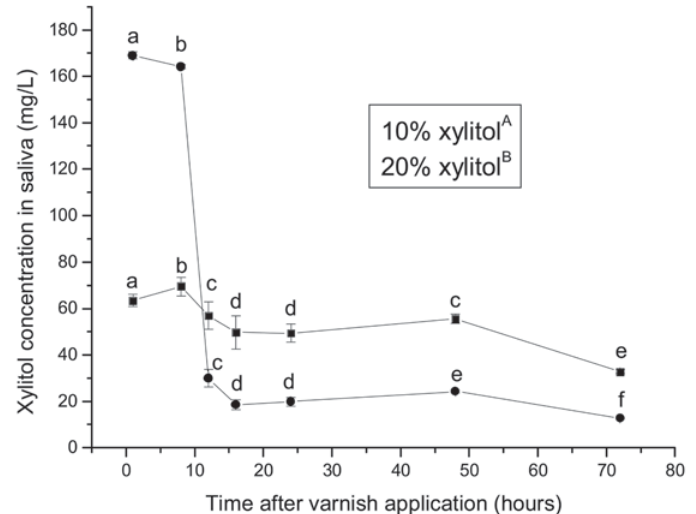
Figure 1- (cid:2)(cid:3)(cid:4)(cid:5)(cid:6)(cid:2)(cid:5)(cid:7)(cid:7)(cid:8)(cid:9)(cid:8)(cid:10)(cid:5)(cid:11)(cid:4)(cid:12)(cid:2)(cid:13)(cid:14)(cid:10)(cid:15)(cid:11)(cid:16)(cid:10)(cid:2)(cid:7)(cid:16)(cid:6)(cid:7)(cid:4)(cid:6)(cid:11)(cid:17)(cid:5)(cid:11)(cid:15)(cid:16)(cid:6)(cid:18)(cid:2)(cid:19)(cid:9)(cid:20)(cid:21)(cid:22)(cid:23)(cid:2)(cid:15)(cid:6)(cid:2)(cid:5)(cid:17)(cid:11)(cid:15)(cid:24)(cid:7)(cid:15)(cid:5)(cid:10)(cid:2)(cid:18)(cid:5)(cid:10)(cid:15)(cid:25)(cid:5)(cid:2)(cid:16)(cid:25)(cid:4)(cid:17)(cid:2)(cid:11)(cid:15)(cid:9)(cid:4)(cid:2)(cid:5)(cid:26)(cid:11)(cid:4)(cid:17)(cid:2)(cid:5)(cid:27)(cid:27)(cid:10)(cid:15)(cid:7)(cid:5)(cid:11)(cid:15)(cid:16)(cid:6)(cid:2)(cid:16)(cid:26)(cid:2)(cid:28)(cid:29)(cid:30)(cid:2)(cid:5)(cid:6)(cid:12)(cid:2)(cid:31)(cid:29)(cid:30)(cid:2) (cid:13)(cid:14)(cid:10)(cid:15)(cid:11)(cid:16)(cid:10)(cid:2)(cid:25)(cid:5)(cid:17)(cid:6)(cid:15)(cid:18)!(cid:4)(cid:18)"(cid:2)#(cid:5)(cid:17)(cid:18)(cid:2)(cid:15)(cid:6)(cid:12)(cid:15)(cid:7)(cid:5)(cid:11)(cid:4)(cid:2)$%(cid:2)(cid:19)(cid:6)&’(cid:23)"(cid:2)%(cid:15)(cid:18)(cid:11)(cid:15)(cid:6)(cid:7)(cid:11)(cid:2)(cid:8)(cid:27)(cid:27)(cid:4)(cid:17)(cid:7)(cid:5)(cid:18)(cid:4)(cid:2)(cid:10)(cid:4)(cid:11)(cid:11)(cid:4)(cid:17)(cid:18)(cid:2)(cid:15)(cid:6)(cid:12)(cid:15)(cid:7)(cid:5)(cid:11)(cid:4)(cid:2)(cid:18)(cid:15)(cid:20)(cid:6)(cid:15)(cid:24)(cid:7)(cid:5)(cid:6)(cid:11)(cid:2)(cid:12)(cid:15)(cid:26)(cid:26)(cid:4)(cid:17)(cid:4)(cid:6)(cid:7)(cid:4)(cid:18)(cid:2)((cid:4)(cid:11))(cid:4)(cid:4)(cid:6)(cid:2)(cid:11)!(cid:4)(cid:2)(cid:25)(cid:5)(cid:17)(cid:6)(cid:15)(cid:18)!(cid:4)(cid:18)"(cid:2)